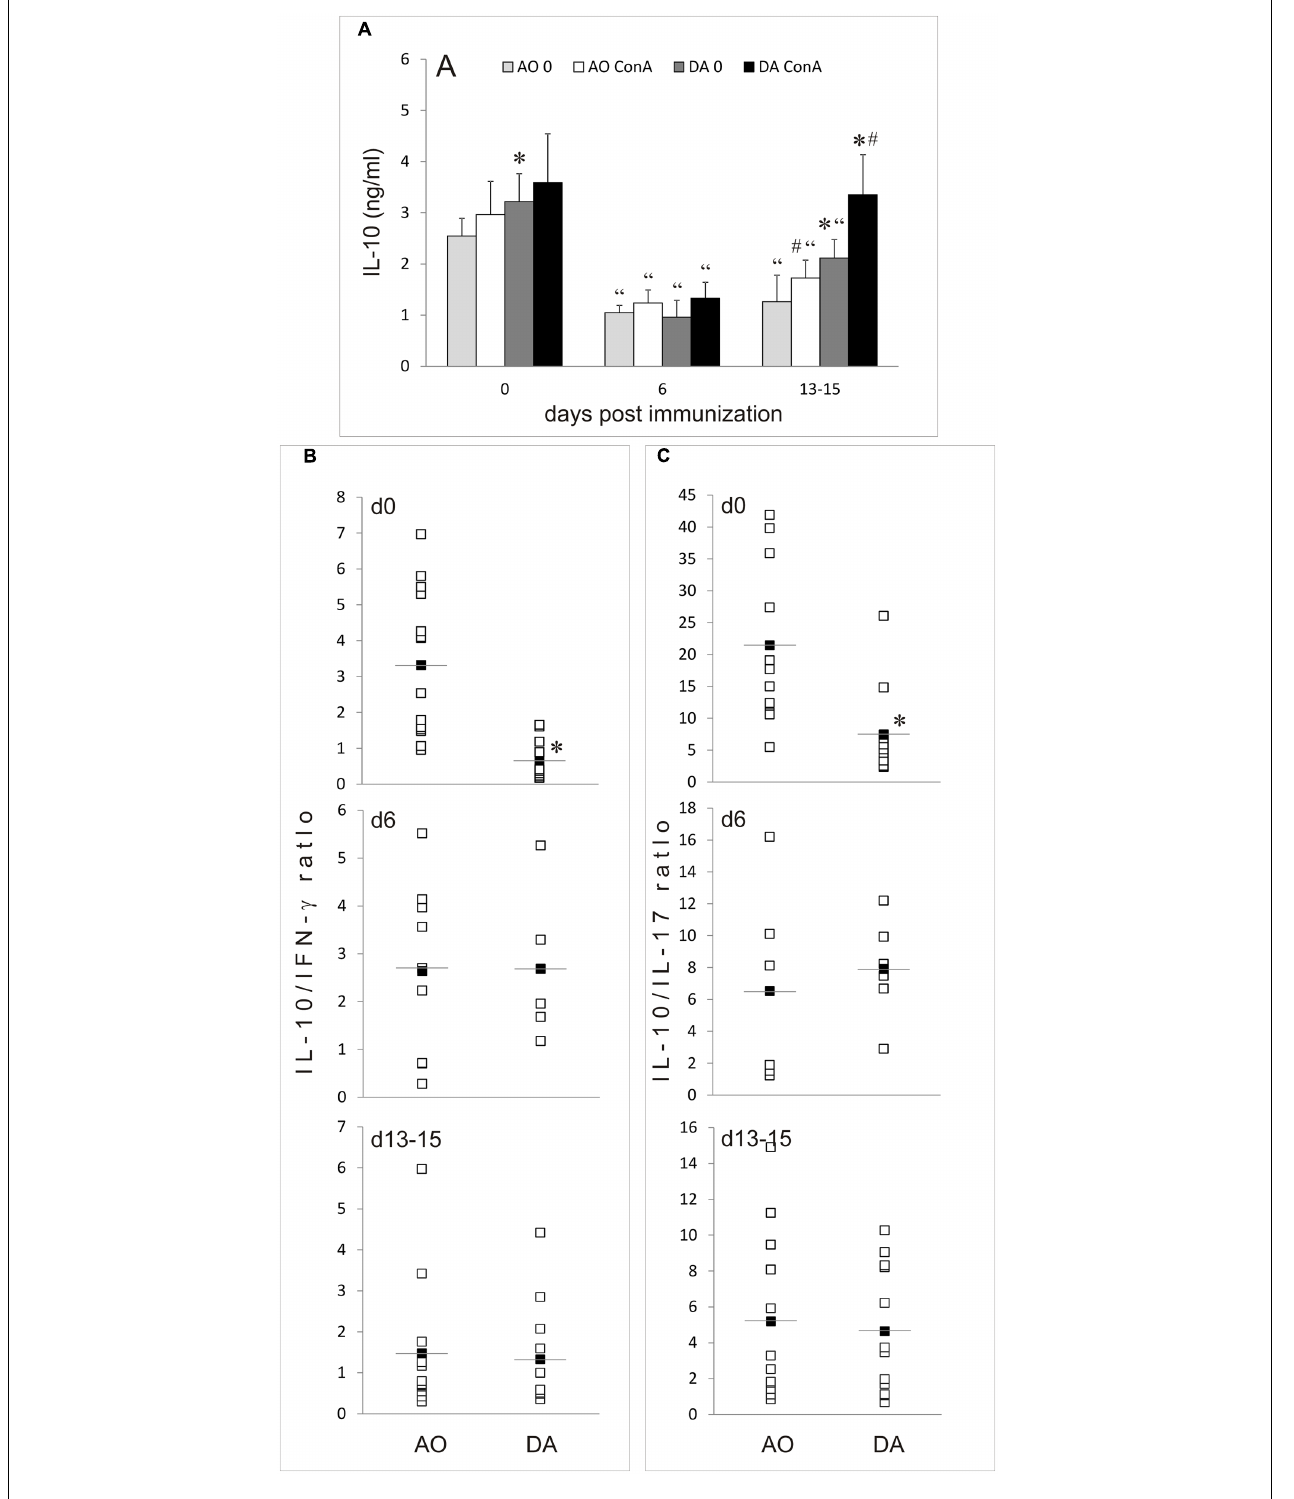
FIGURE 5 | IL-10 production in PPC. PPC were isolated from non-immunized (0 d.p.i.) AO and DA rats or from immunized rats at 6 d.p.i and 13–15 d.p.i. Cytokine levels were measured in supernatants of 24 h cultures of un-stimulated (0) or ConA-stimulated (ConA) cells. IL-10 levels are presented as mean ± SD from at least six rats per group (A) . Ratios of IL-10 levels to IFN- γ (B) or to IL-17 (C) levels determined in ConA-stimulated cultures are presented as individual values (white squares) and as mean (black squares with line). ∗ p < 0.05 AO vs. DA; “ p < 0.05 to 0 d.p.i. of the same strain; # p < 0.05 0 vs. ConA.